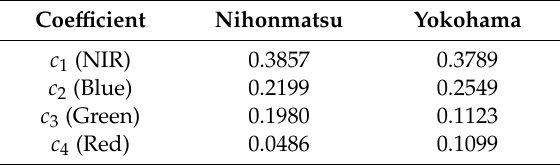
Table 2. The correction coe ffi cient estimated by